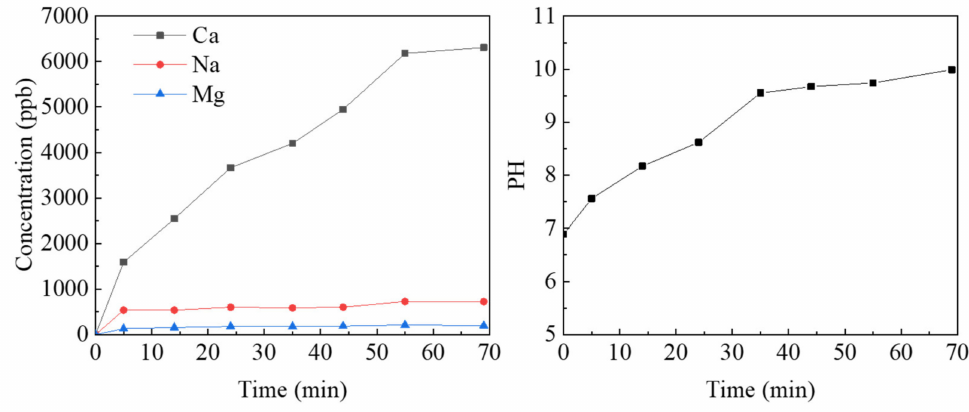
Figure 19. The analysis of chemical composition ( left ) and PH value ( right ) in leaching